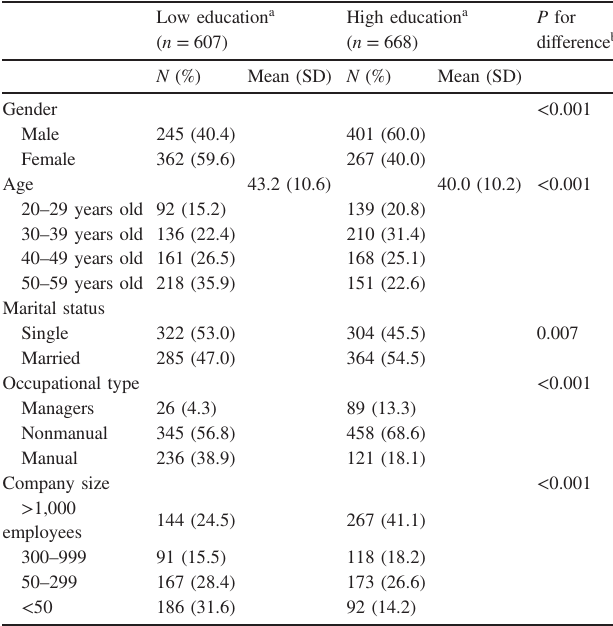
Table 1. Baseline characteristics of participants strati fi ed by level of educational attainment ( N = 1,275)